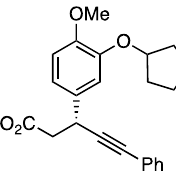
Figure 8. Compounds synthesized by using propargylic substitution 1 . 1 Phosphate 80 and Grignard reagent 81 were used for the synthesis of heliannuol E.